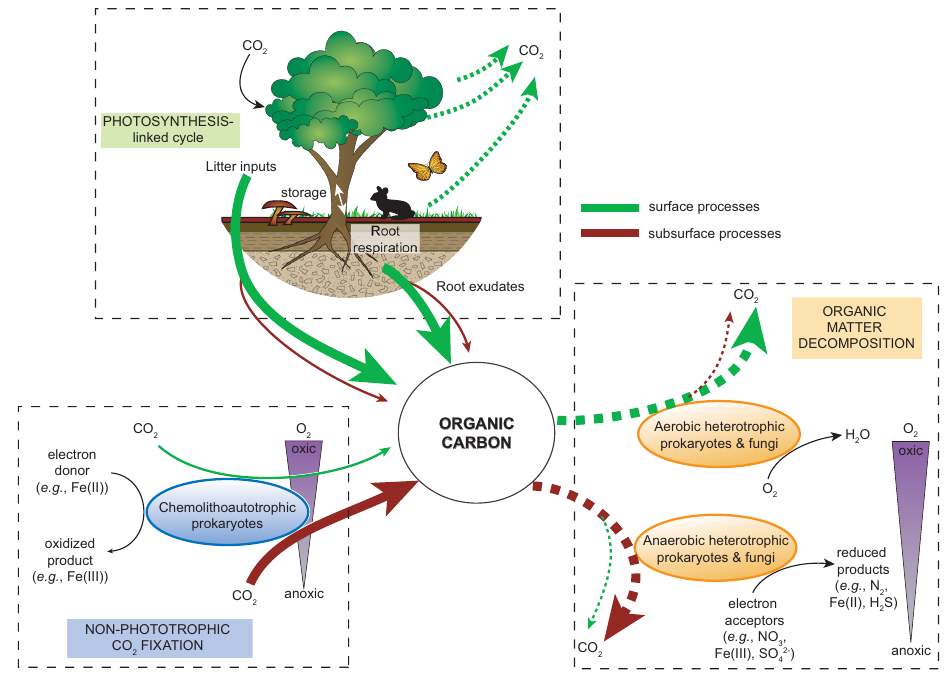
Fig. 2. The CZ biological cycle. Illustrated are the major pathways in which fixed carbon enters (solid arrows) and leaves (dashed arrows) the CZ. The intensity of each pathway varies depending on location and is reflected by the size of the arrow. Arrows in green indicate the contribution of processes to surface habitats, whereas arrows in red reflect contributions to subsurface